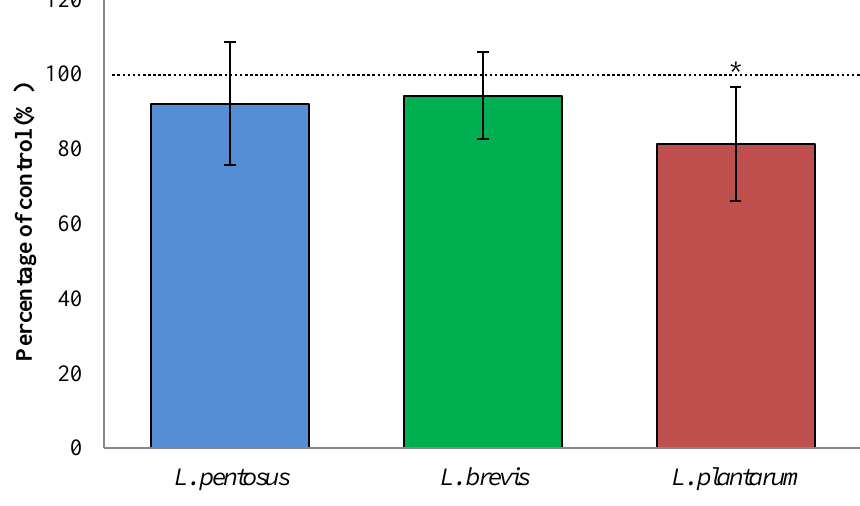
Figure 3. The change in the number of TG2 binding motif QLP in α 2 -gliadin from in vitro digested sourdough breads. The sourdough was fermented with L. brevis , L. pentosus , or L. plantarum . Changes were compared to those from unfermented control breads (control = 100%). Data are presented as means ± SD ( n = 8–12). The asterisk indicates